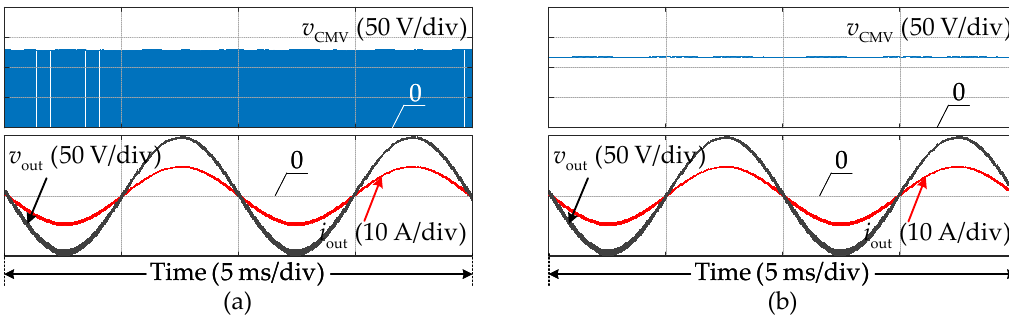
Figure 8. Simulation results of the CMV v cmv , output voltage v out and output voltage i out when the RSPWM strategy is used in ( a ) the conventional three-phase qZSI system and ( b ) the modified three-phase qZSI system [Time (5